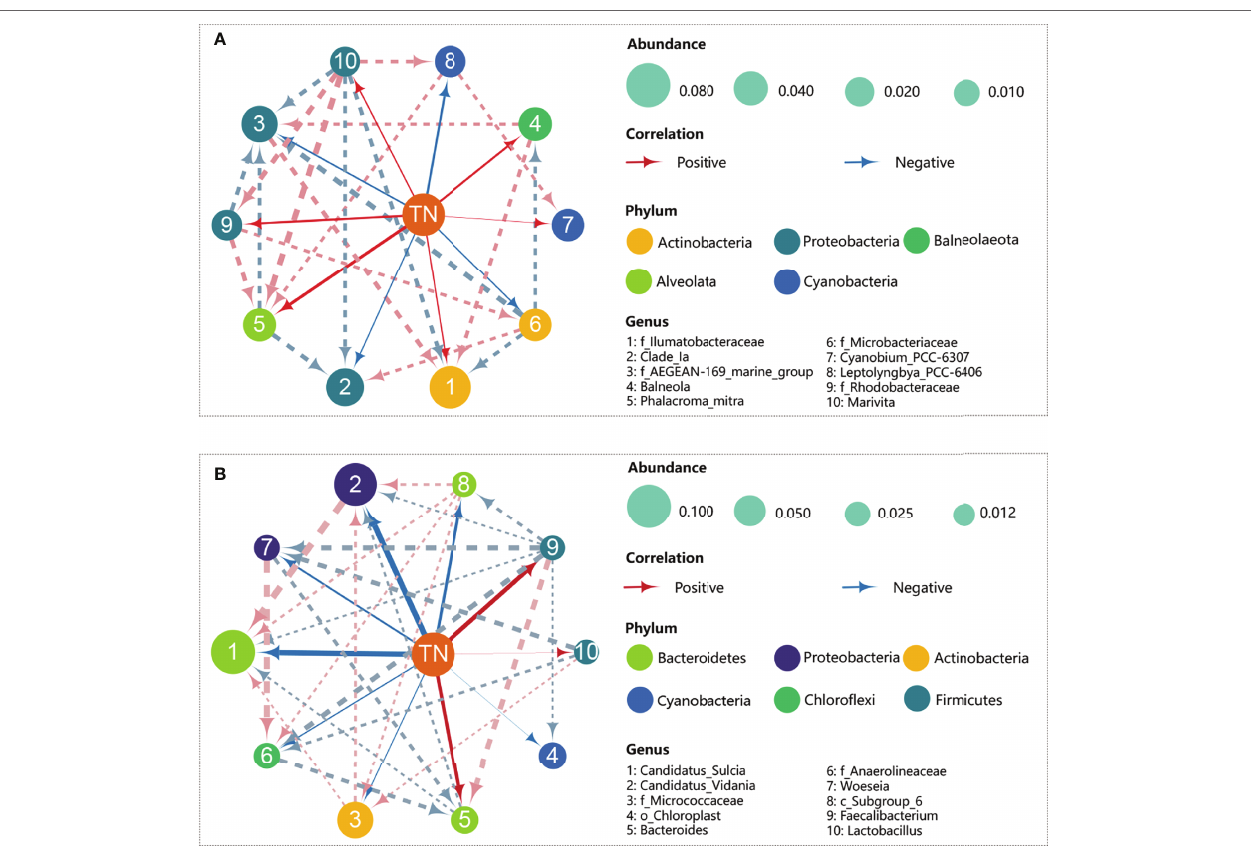
FIGURE 3 | Bacterial interaction networks in water (A) and sediment (B) based on Spearman rank correlation analysis. Top 10 bacterial genera with high absolute abundances were selected for correlation analysis. A connection implies a strong (Spearman’s |r|>0.4) and significant ( p <0.05 after FDR correction). The size of each node represents the degree of abundance, the thickness of each line represents the degree of correlation, and the color of each node represents the specified phylum. The dotted and solid lines indicate the bacteria-bacteria and nitrogen-bacteria interactions, respectively. The red and blue lines indicate positive and negative relationships, respectively.